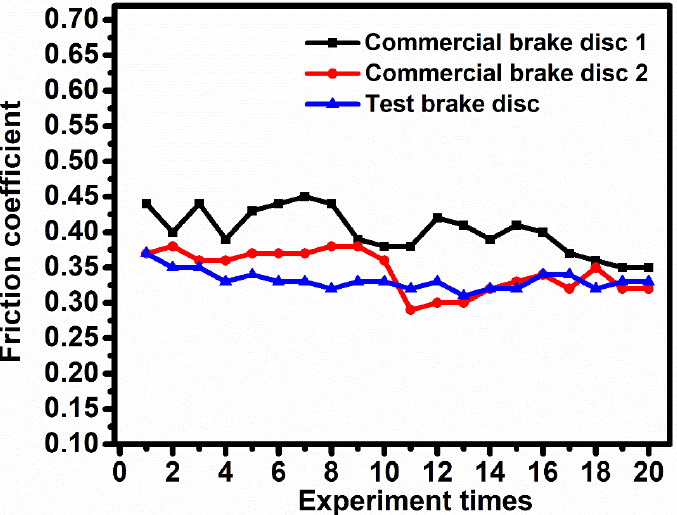
Figure 9. Variations in the friction coefficients of the three C/C brake discs with the number of braking tests. Table 4. Distributions of the friction coefficient measurements of the three C/C brake discs (based on data from the first 20 tests at the design landing energy).